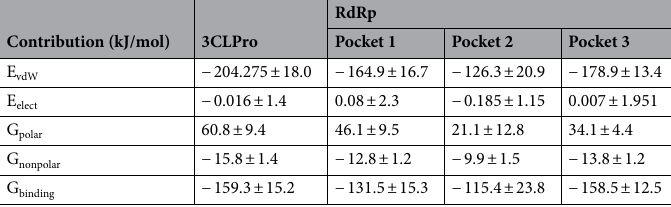
Table. 1. The energetic parameters obtained from MMPBSA